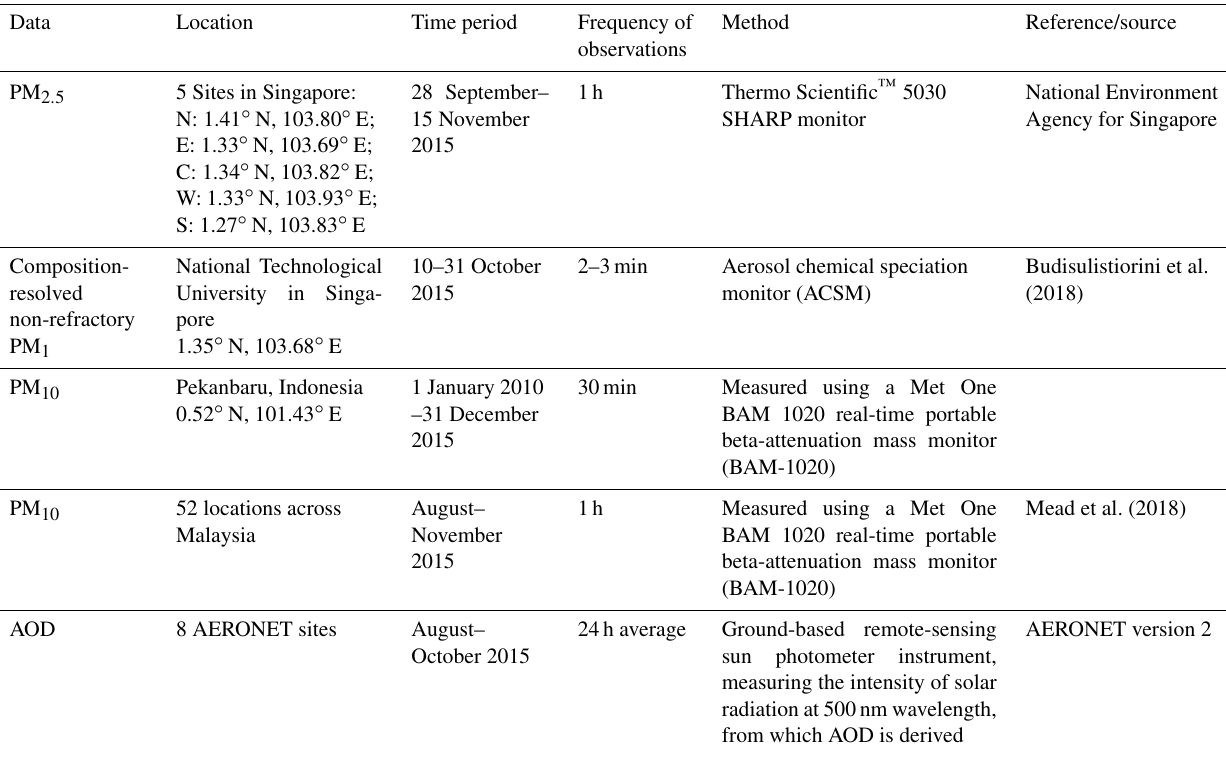
Table 3. Observational data for